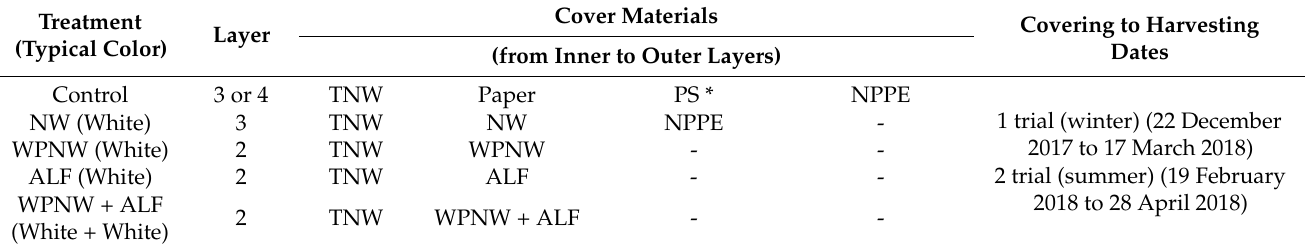
Table 1. Five cover material treatments.